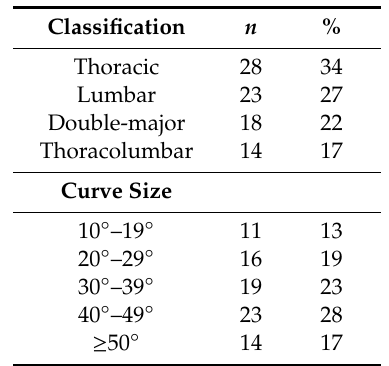
Table 2. Curve characteristics of participants.